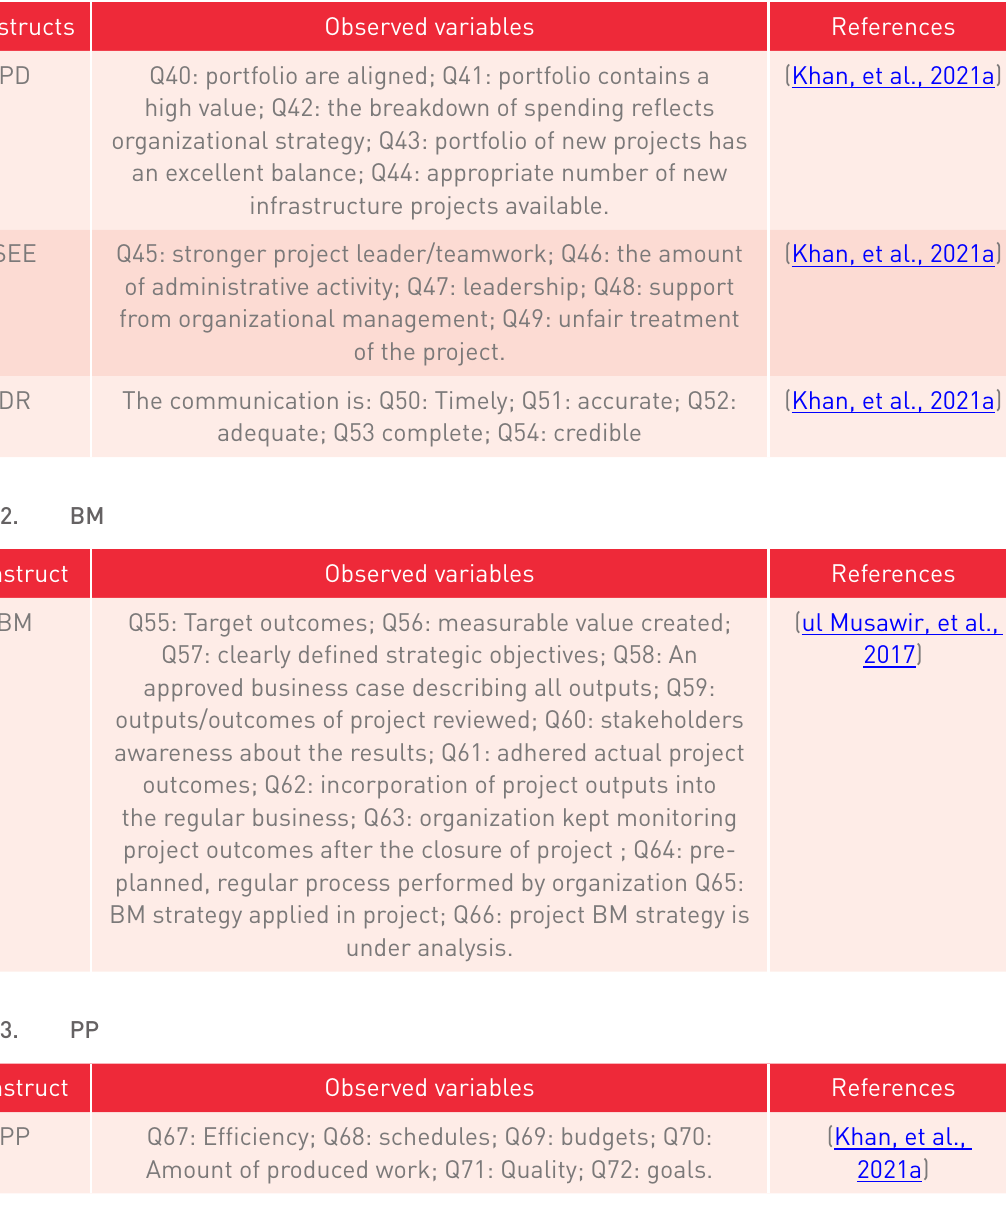
PP Construct Observed